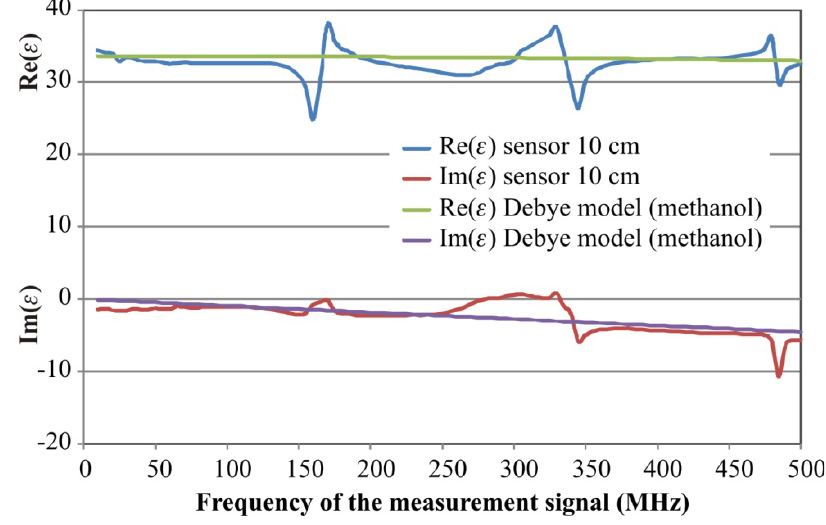
model for the FDR sensor with 10 cm length of T